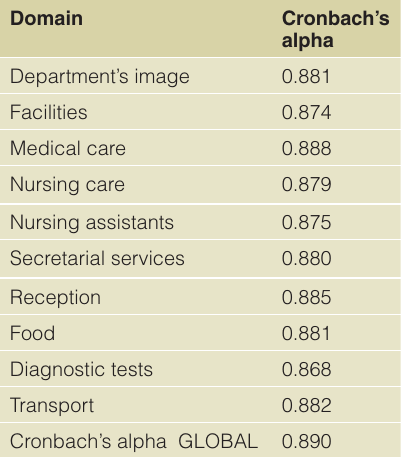
Table 2. Grouping of domains with their respective Cronbach’s alphas.